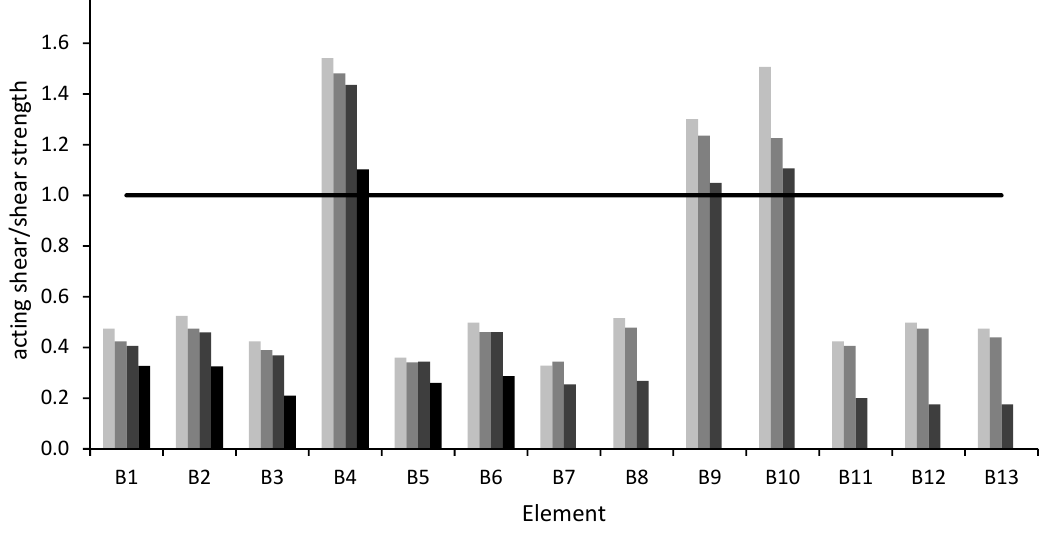
Figure 6. Shear verifications of beams in as-built condition.